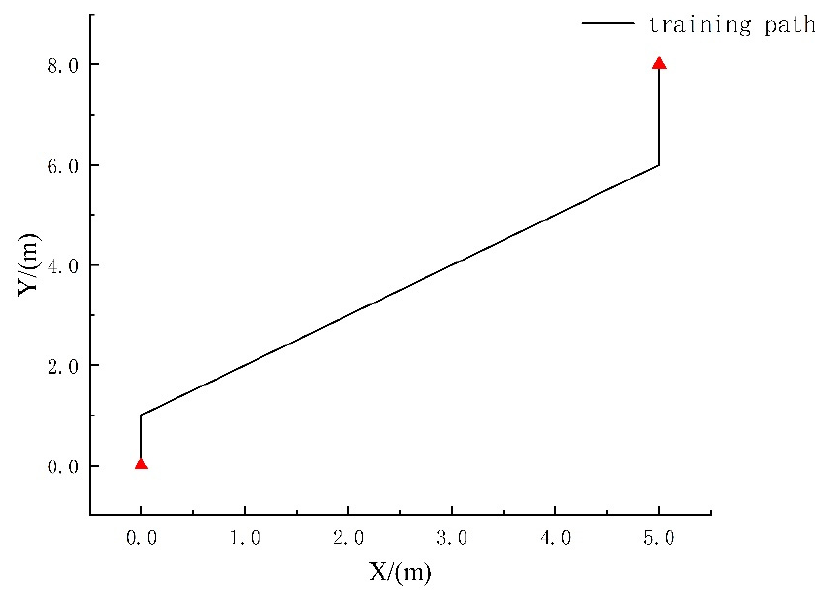
Figure 10. Schematic illustration of reference path.